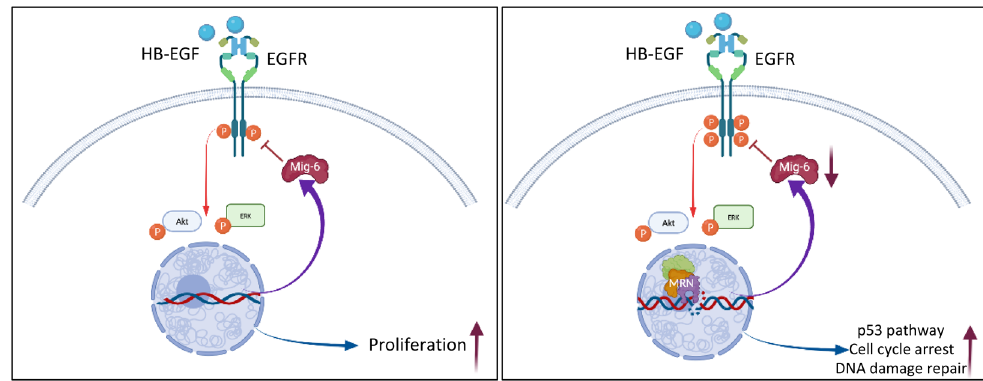
Figure 5. Model effects of DNA damage and repair on EGFR signaling and cellular response. ( A ) Under homeostatic conditions binding of ligand to EGFR induces canonical signals supporting cell proliferation and survival. ( B ) Upon induction of DNA damage, the MRN complex is assembled around sites of DSBs leading to a decrease in Mig-6 expression and amplifies ligand-induced EGFR signaling. In turn, amplified EGFR signaling enhances DDR-induced p53 pathway and cell cycle arrest and facilitates DSBs rejoining. Images created using